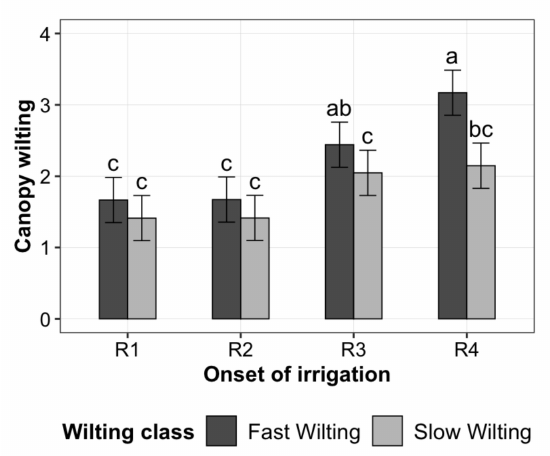
Figure 4. Canopy witling of each wilting class under different onset irrigations (R1, R2, R3, and R4). Same letters are not significantly different (Tukey’s; p -value < 0.05). Whiskers denote standard error of the mean.